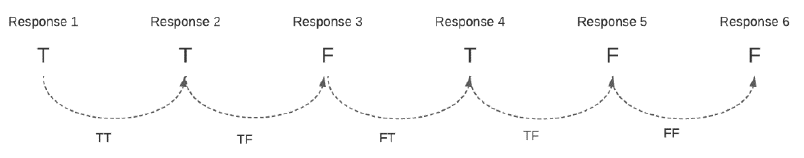
Figure 15. Transition states example.